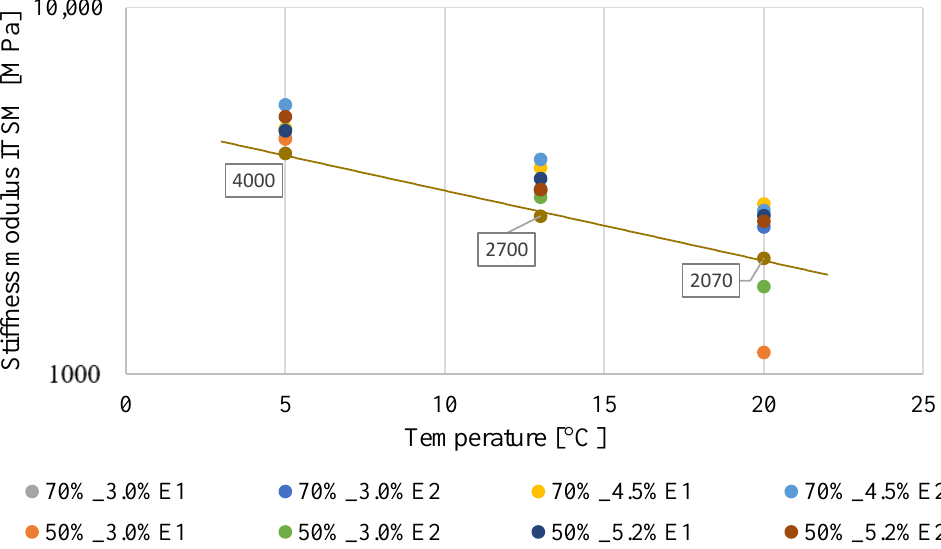
Figure 10. Regression curve for the specified BSM-E stiffness values at 5 °C, 13 °C, and 20 °C.